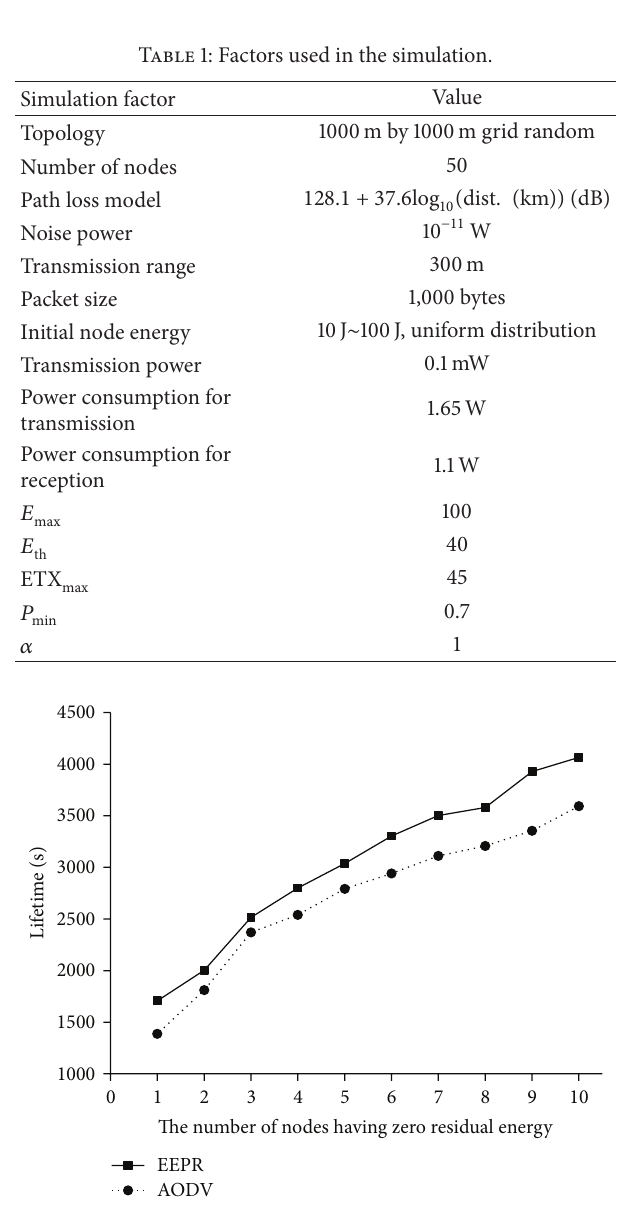
Figure 6: Time as a function of the number of nodes having zero residual energy.